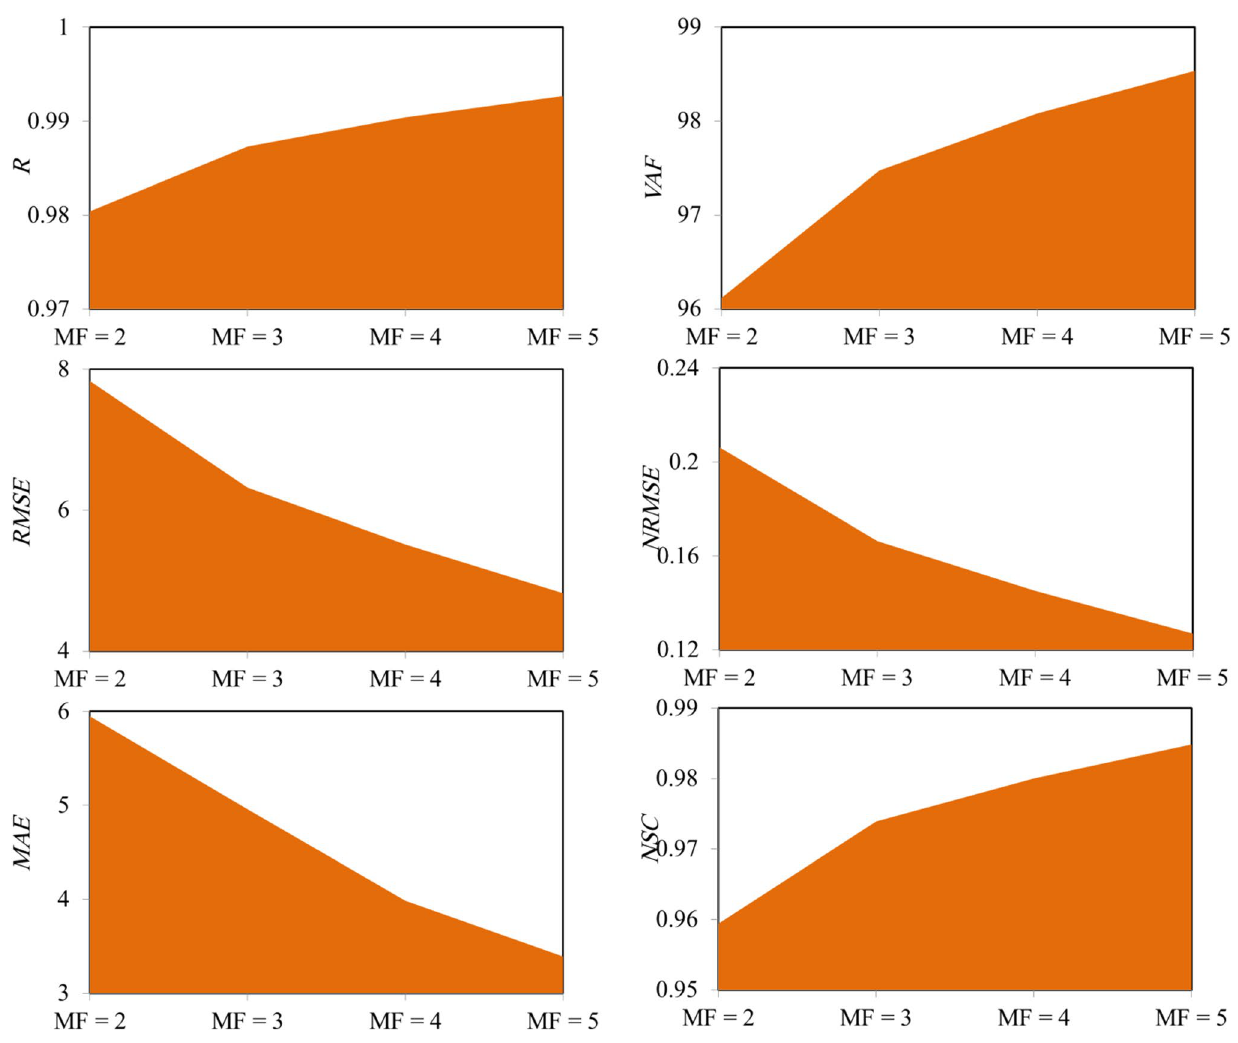
Fig. 9 Comparison of different statistical indices for the number of MFs from two to five